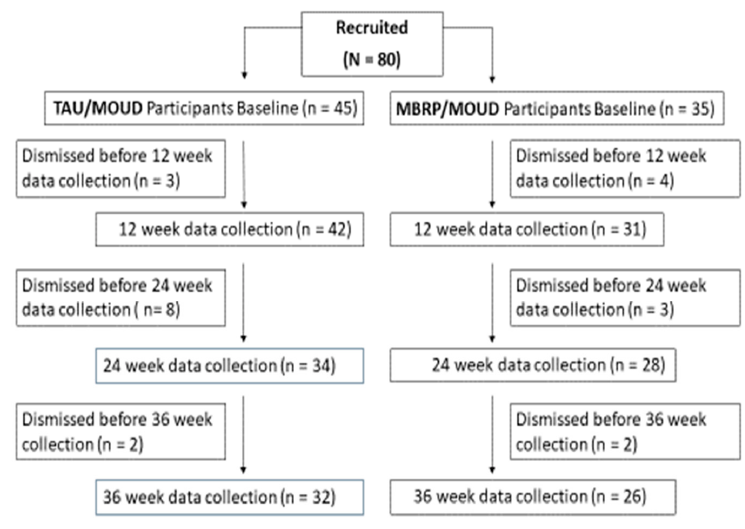
Figure 1. Intervention flowchart. Table 1. MBRP Intervention Demographic Data by Group and Total (N =